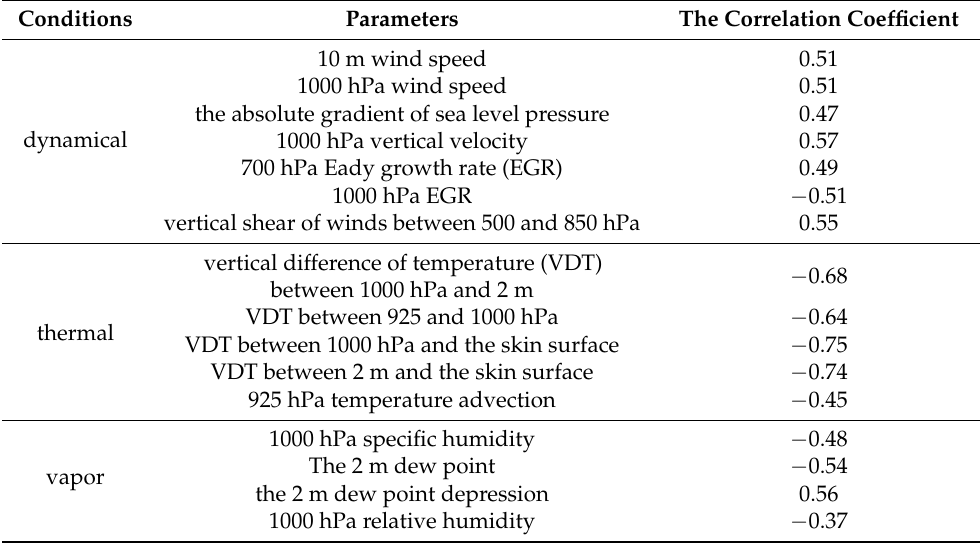
Table 1. The summarization of the correlation coefficients of kinds of meteorological dynamical, thermal and vapor factors with the daily averaged visibility over Jiangsu Province in China. All the correlations exceed the 0.01 significance